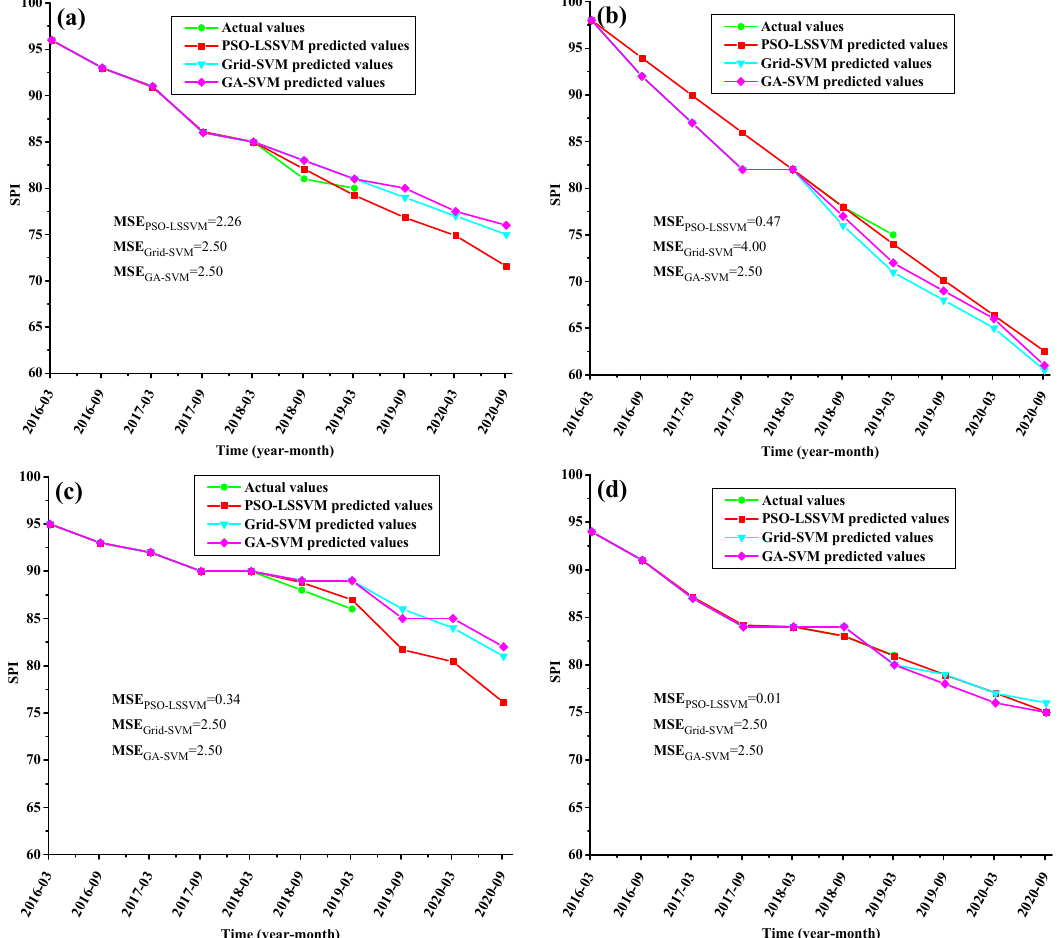
Figure 8. Comparison of the prediction values and the actual values of SPI: ( a ) K2452–K2453 of G105; ( b ) K95–K96 of S223; ( c ) K103–K104 of S270; ( d ) K9–K10 of S356. Table 4. Optimized parameters of the PSO–LSSVM model for the four test sites.